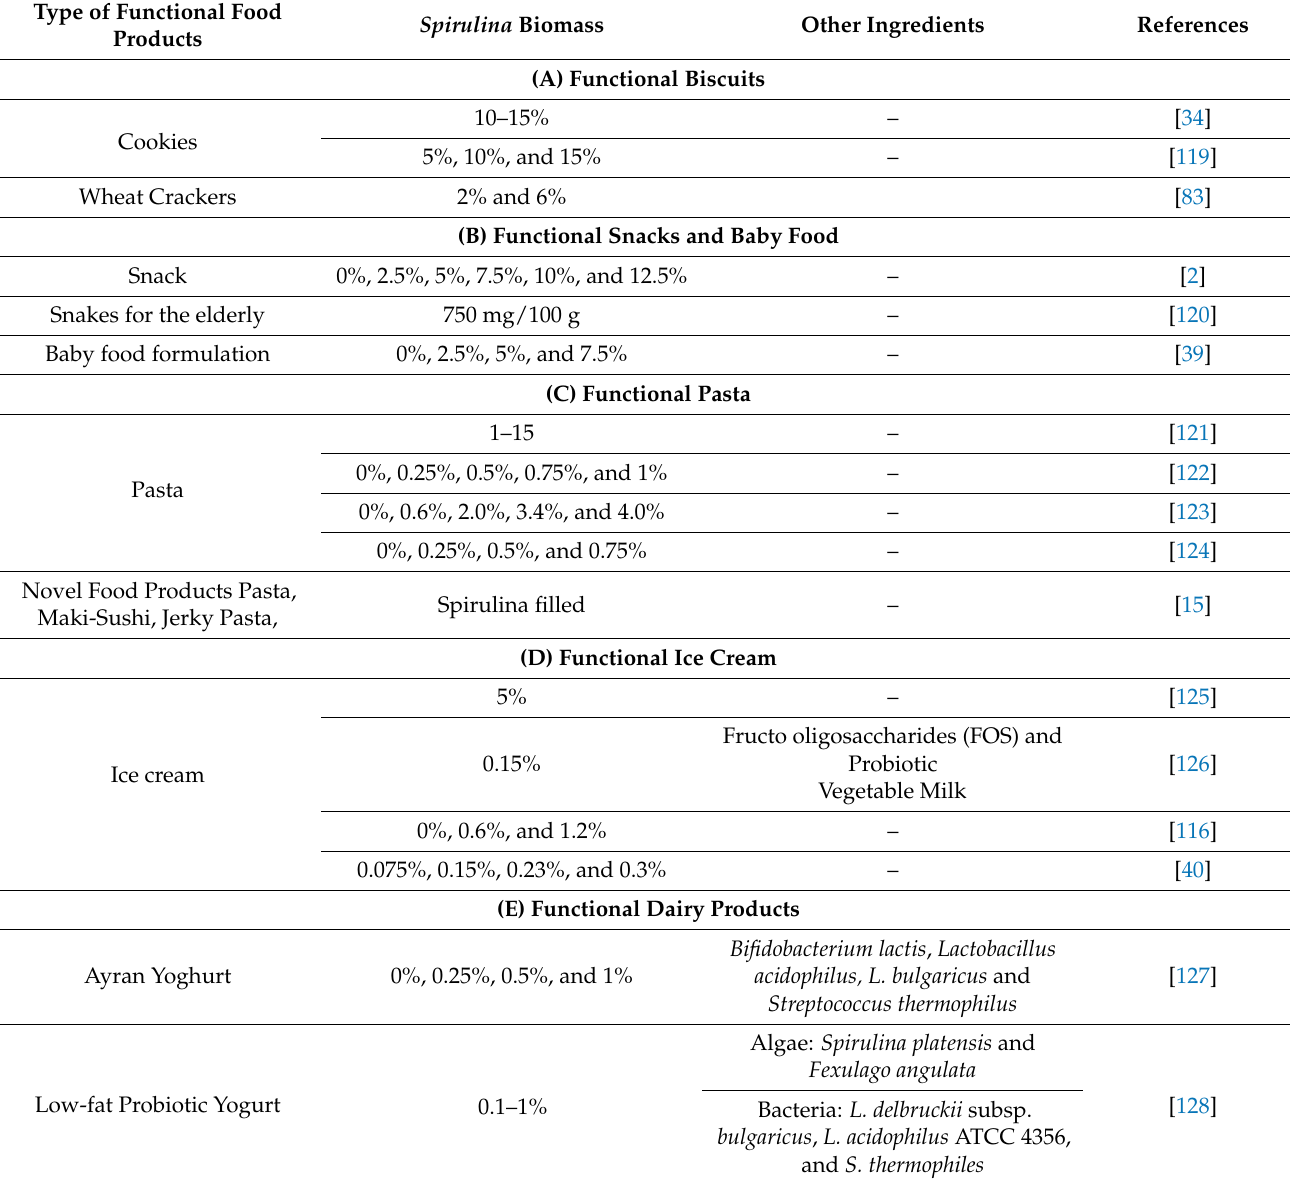
Table 3. Various developed functional food products with incorporation of spirulina